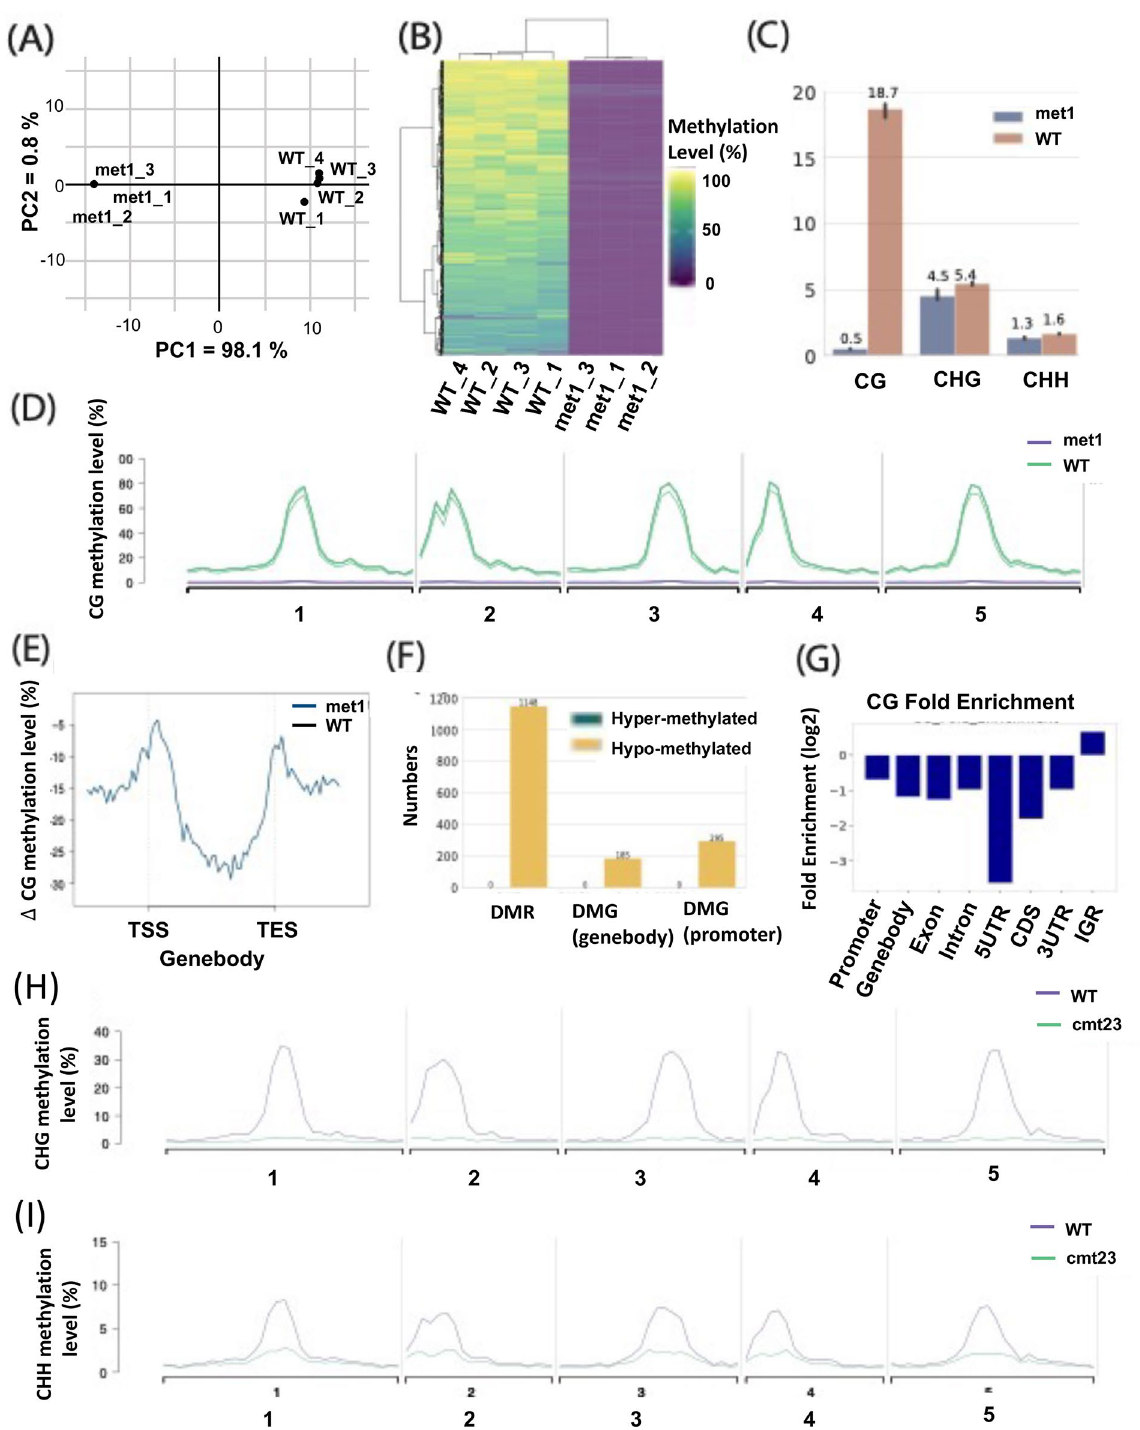
Fig. 2 Visualization of Arabidopsis genomewide methylation analysis ( A ) PCA and ( B ) Hierarchical clustering showed a clear difference between met1 and wild‑type (WT). C The average methylation level in two genotypes in 3 contexts (CG, CHG, CHH). D The CG methylation level in genome‑wide view. E Metagene plot of Δ CG methylation levels in met1. F The summary of DMR and DMG numbers. G DMRs enriched in IGR. The CHG ( H ) and CHH ( I ) methylation level of cmt2 cmt3 double mutant and wild‑type in genome‑wide view. TSS transcription start site, TES transcription end site, 5 ′ UTR 5 ′ untranslated region, CDS coding sequence, 3’UTR 3 ′ untranslated